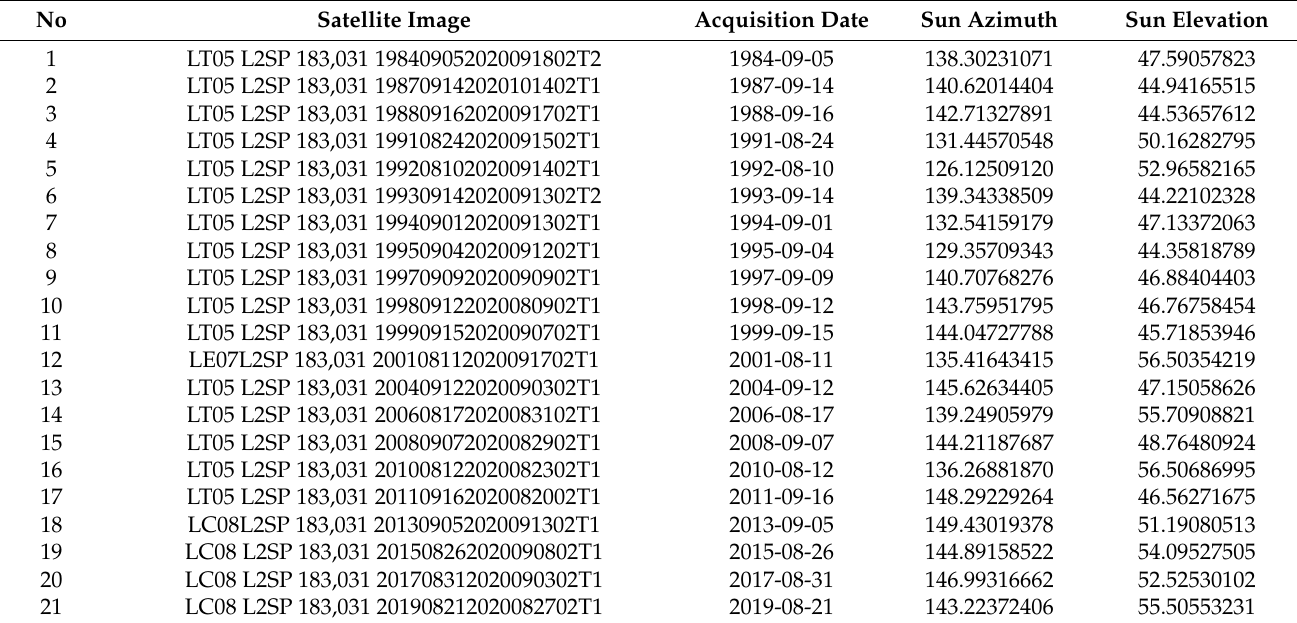
Table 1. Satellite Images used in the study.